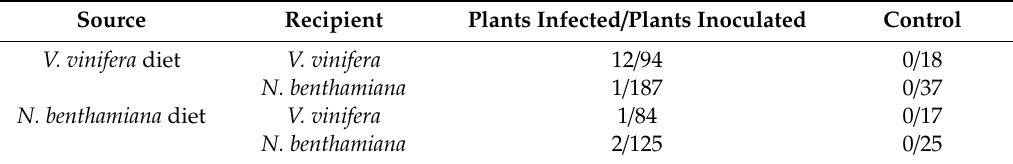
Table 1. Planococcus ficus transmits GLRaV-3 from purified virus fed through a membrane system. GLRaV-3 was purified from both Vitis vinifera and P1 / HC-Pro Nicotiana benthamiana source plants and successfully transmitted by insect vectors feeding on artificial diets with an acquisition access period of 24 h followed by a four-day inoculation access period on test plants. All trials included P. ficus feeding on artificial diet without purified virus as controls.